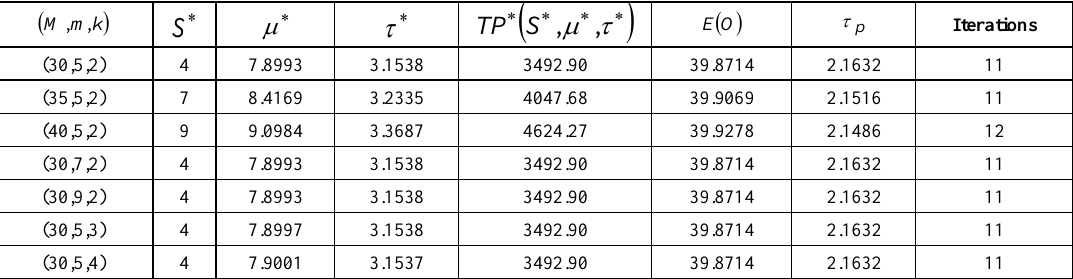
Table 12. Optimal profit analysis wrt design parameters ,, mM and k .